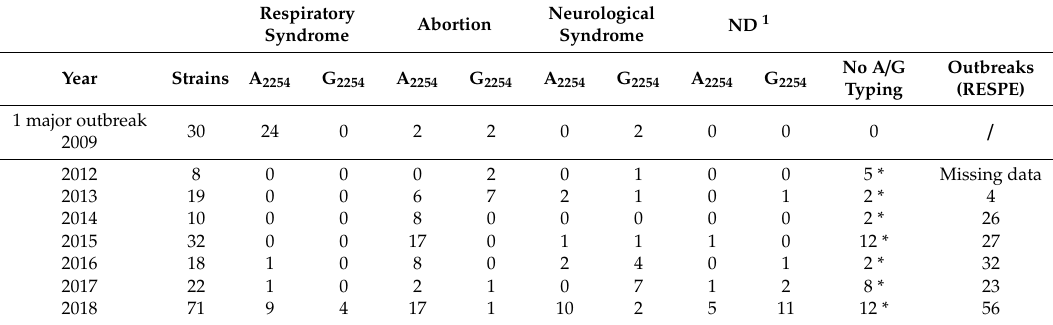
Table 4. Details of EHV-1 strains, per year, disease type, and strain typing (ORF30 A2254G).